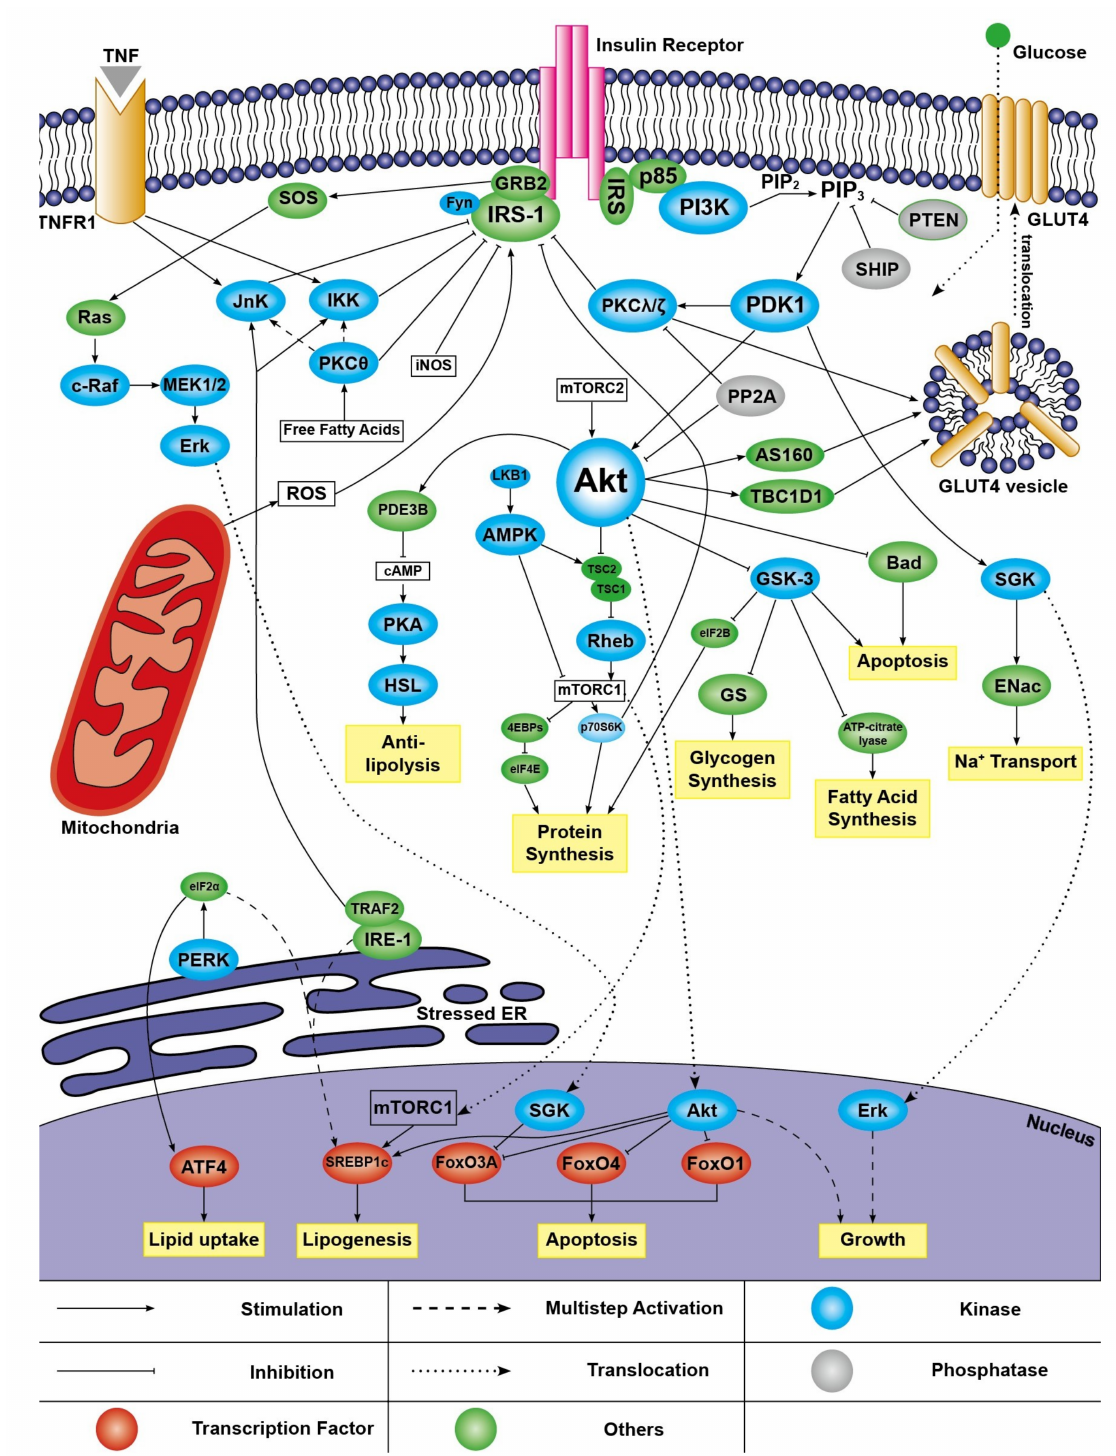
Figure 1. Current concepts of insulin signaling